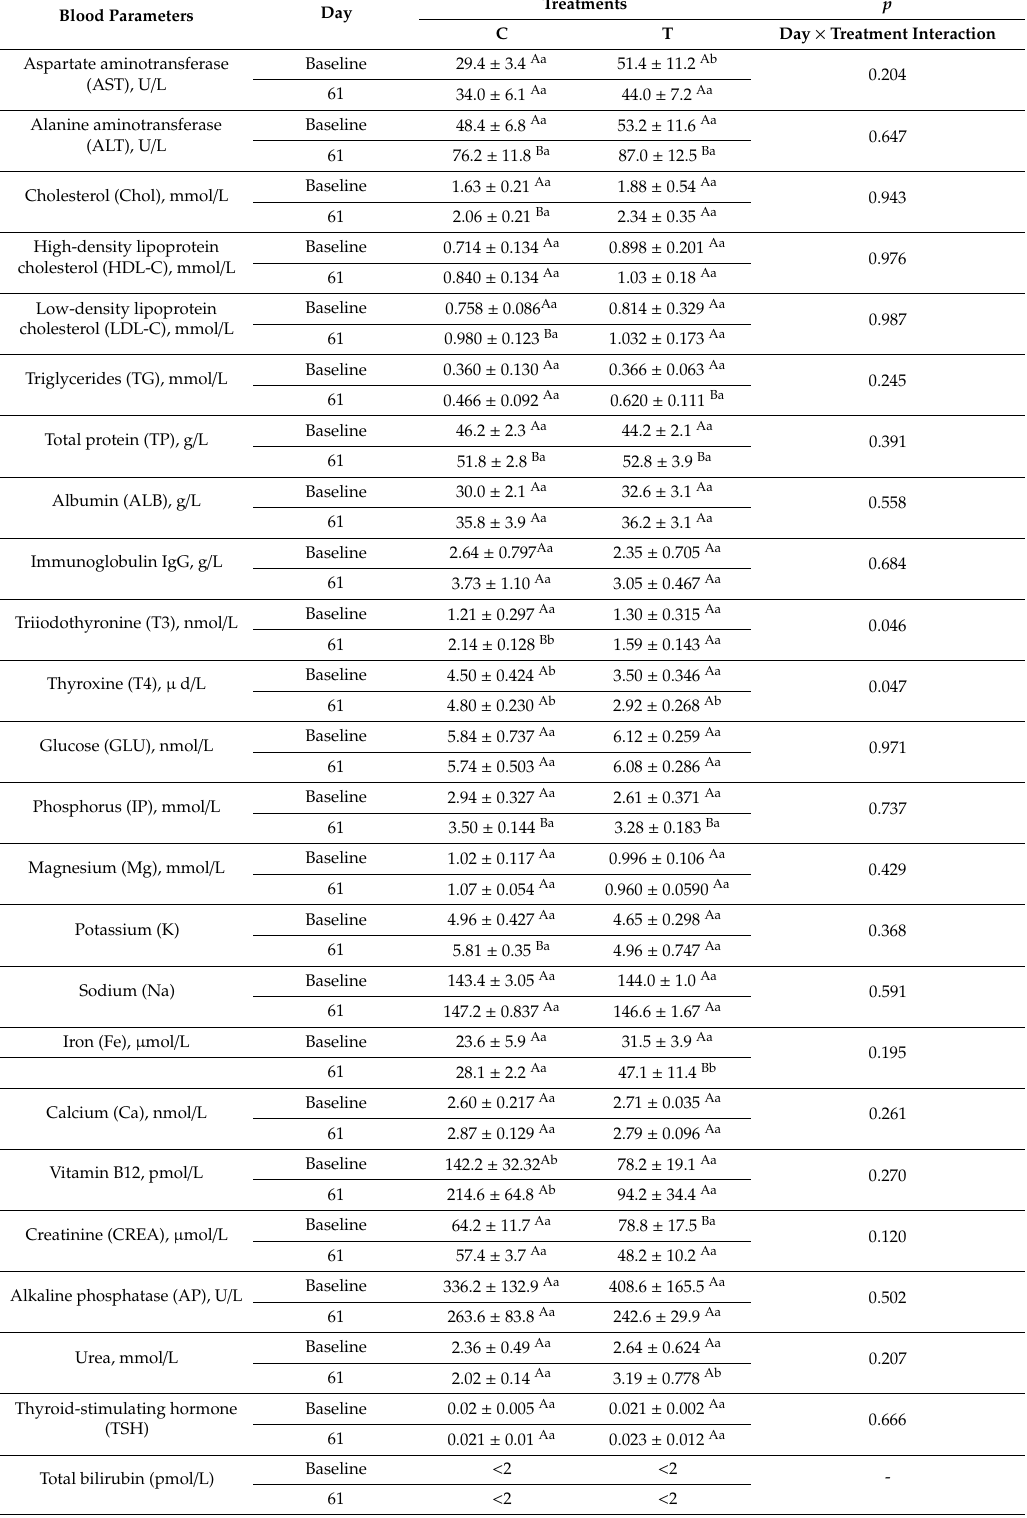
Table 3. Blood parameters of the